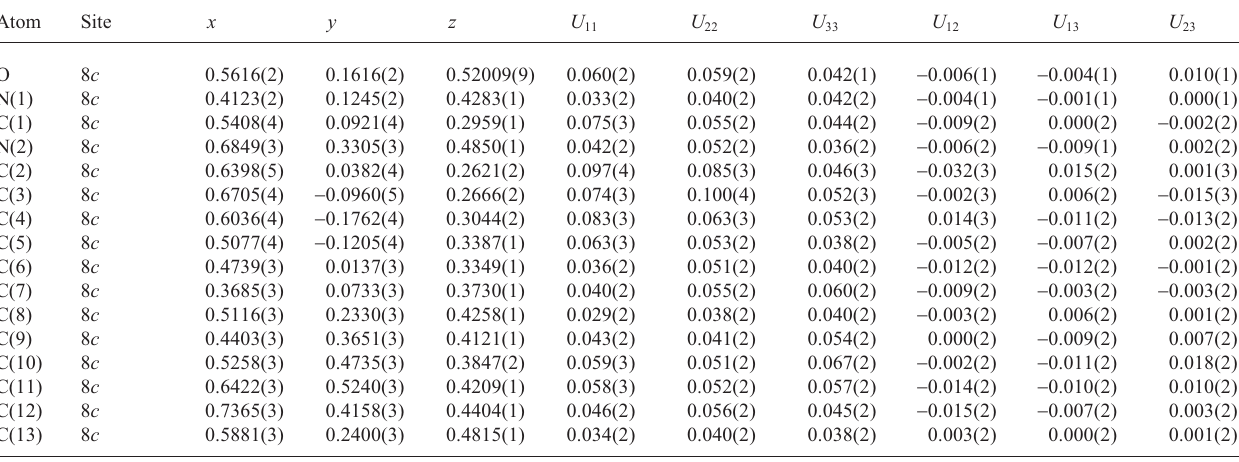
Table 3. Atomic coordinates and displacement parameters (in Å 2 )